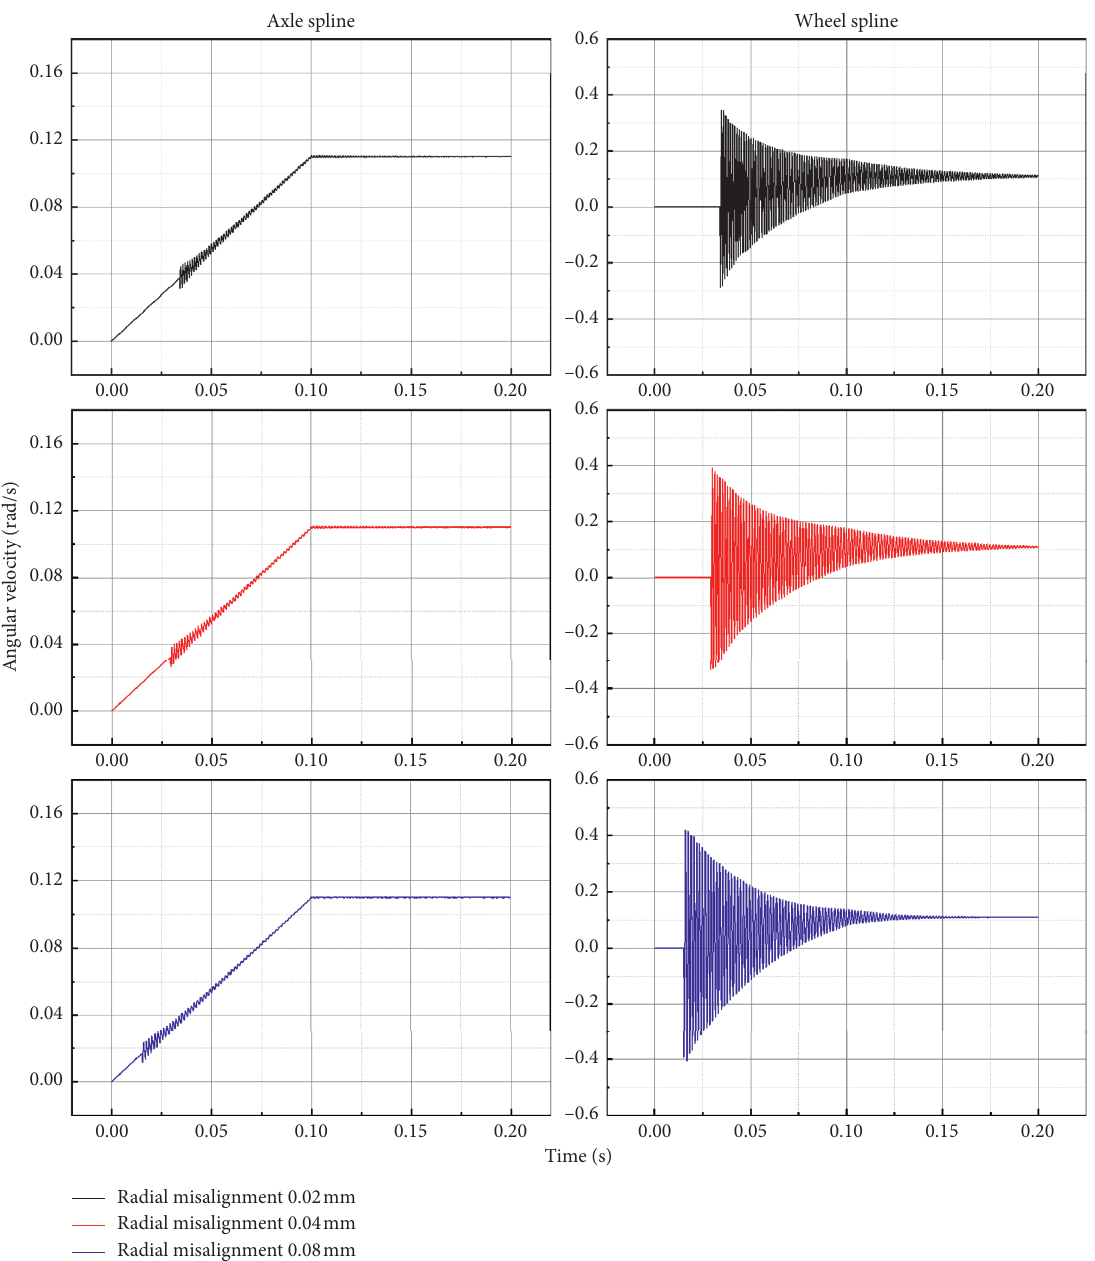
Figure 14: The comparison of angular velocity of spline coupling with different radial misalignments, δ , under identical loading